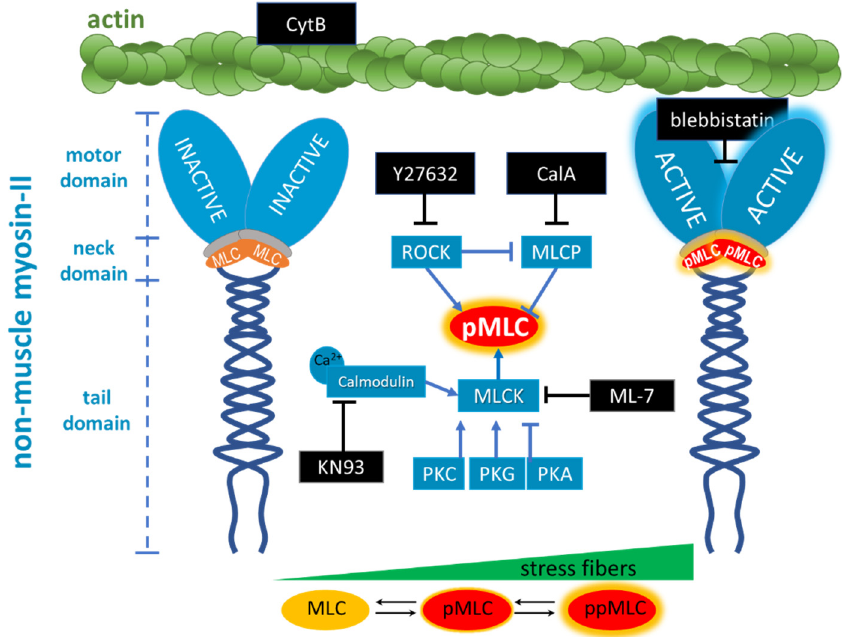
Figure 8. Schematic representation of the action of selected inhibitors used to test the influence of phosphorylation of regulatory myosin light chain (MLC) on fenestrations in LSEC. Phosphorylated MLC (pMLC, glowing red) activates the myosin motor domain that exerts a contractile force on actin. The contractile force generation on actin can be inhibited by blebbistatin independently of MLC phosphorylation. Cytochalasin B (CytB) disturbs actin fibres and therefore weakens the contractile force of the actomyosin complex. KN93, ML-7, and Y27632 inhibit MLC phosphorylation in different ways. Calyculin A (CalA) inhibits MLC phosphatase (MLCP) and prevents MLC dephosphorylation. At the bottom of the figure, it is also highlighted that higher levels of MLC phosphorylation (monophosphorylation (pMLC) and diphosphorylation (ppMLC)) are associated with more prominent actin stress fibres.